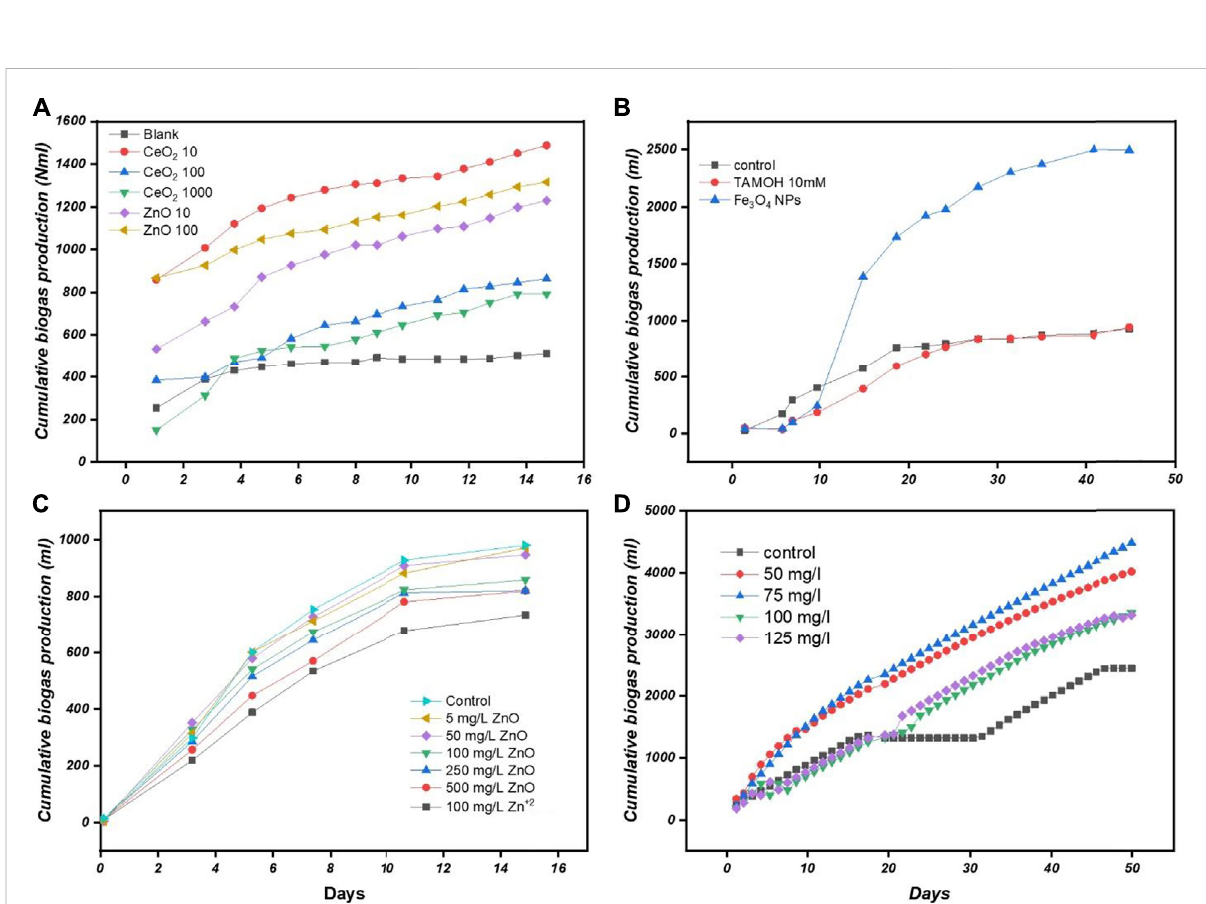
FIGURE 9 (A) In fl uence of Ce O 2 and ZnO NPs on biogas production (Nguyen et al., 2015) (B) Effect of 100ppm Fe 3 O 4 on biogas production (scale bar is 20 nm) (Casals et al., 2014) (C) Effect of ZnO ENMs on production after 14 days (Zhang L. et al., 2017) (D) Cumulative methane production by Fe 3 O 4 NPs (Ali et al.,